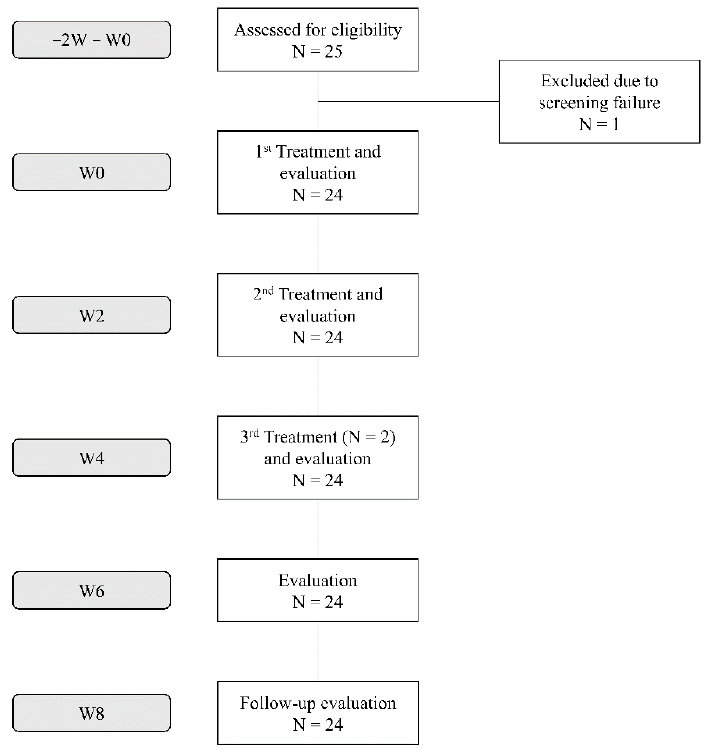
Figure 2. Flowchart of the subjects included in the study.